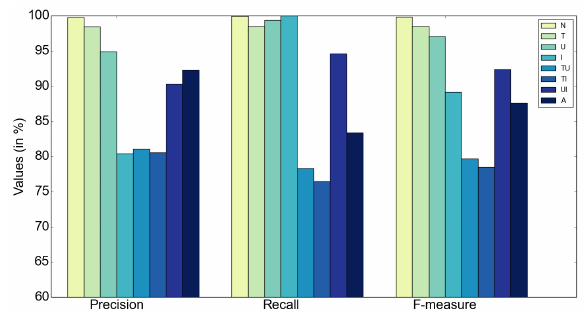
Figure 6. Precision, recall, and f-measure for 8-class